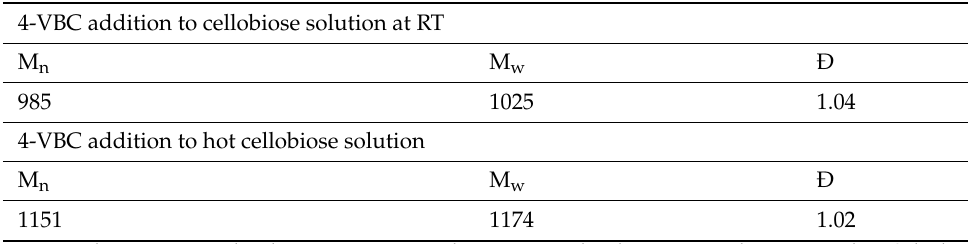
Table 1. Molecular mass characteristics of cellobiose-m depending on temperature. 4-VBC addition to cellobiose solution at RT